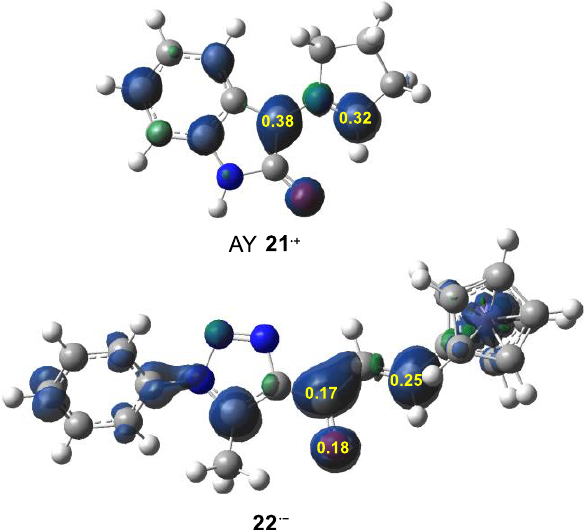
Figure 2. B3LYP/6-31G(d) nucleophilic P k − Parr functions of AY 21 and electrophilic P k+ Parr functions of ferrocene ethylene 22 .